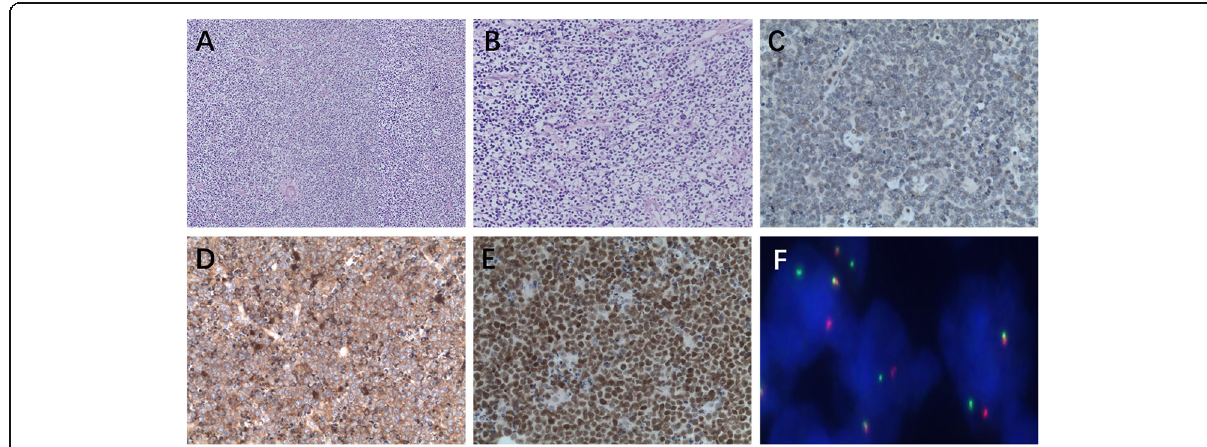
Fig. 1 Burkitt lymphoma showing low- and high-magnification ( a , b ) not LMO2 expression ( c ) but CD38 and c-Myc expression ( d , e ); BL with MYC rearranged ( f )